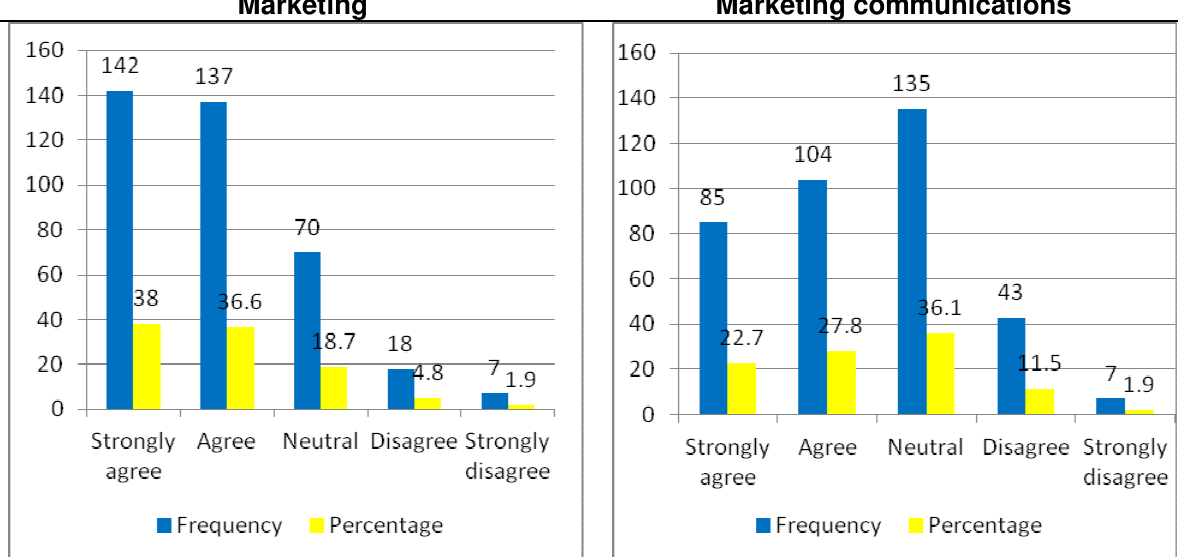
Figure 5: Importance of marketing and marketing communication to business